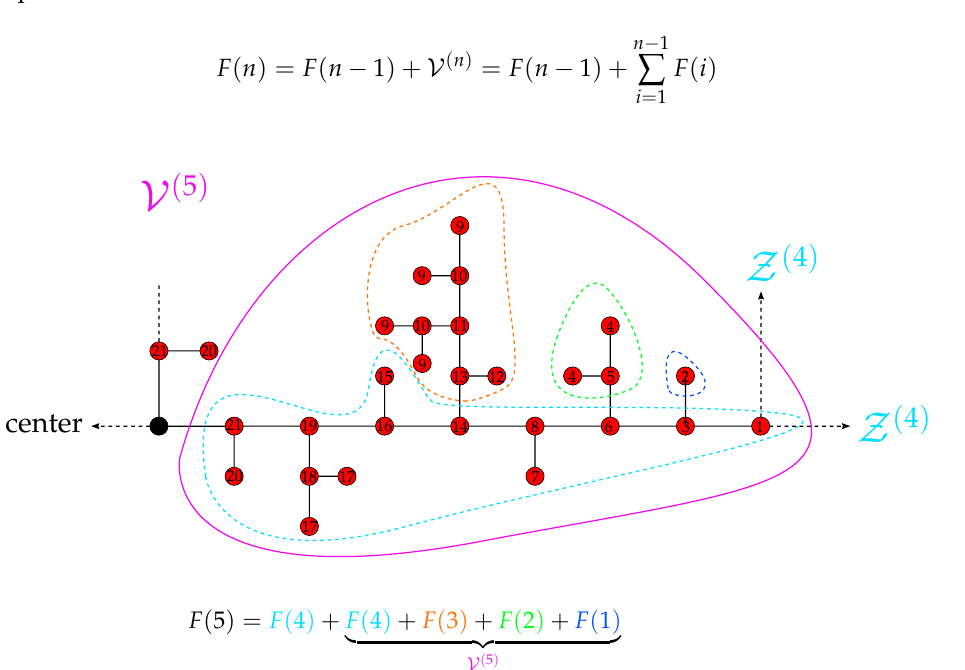
Figure 6. Composition of the number of independent variables F ( 5 ) for the 5th group, see text for details.